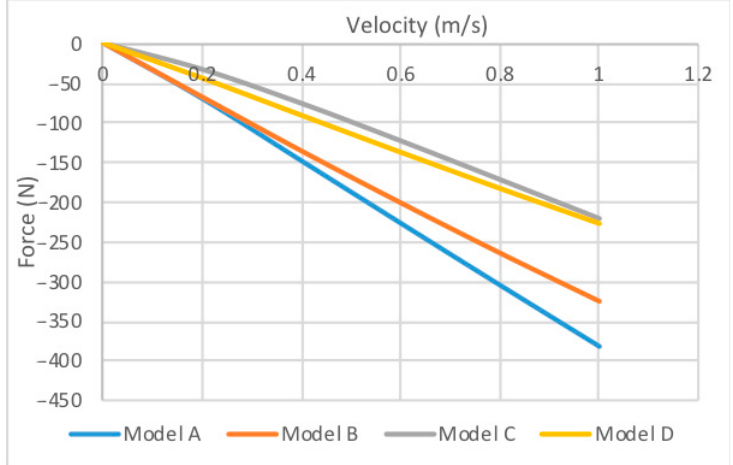
Figure 8. The damping force profiles for the four proposed design cases.